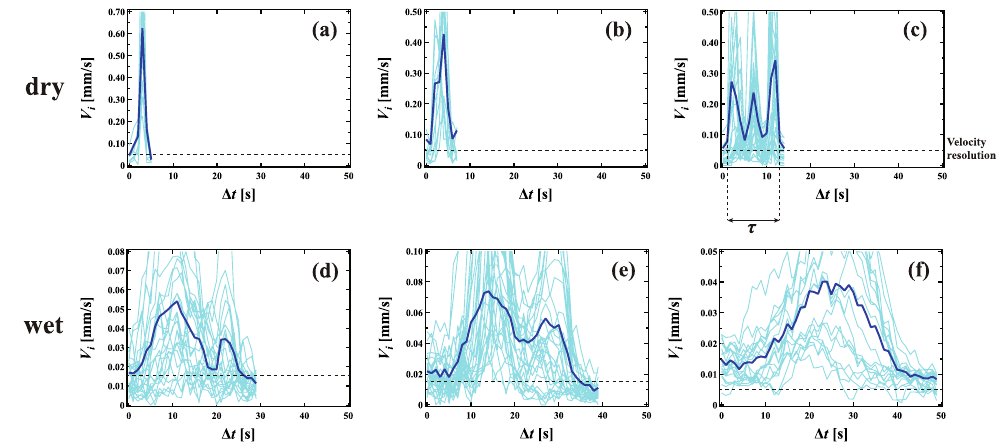
Figure 3. The time evolution of the velocity of the bubbles V i involved in a single collective rearrangement event for φ 2 D = ( a ) 0.019, ( b ) 0.034, ( c ) 0.042, ( d ) 0.047, ( e ) 0.056, and ( f ) 0.066, respectively. The dark blue line shows the mean velocity. We define τ , the characteristic time of a single collective rearrangement event, as the time from the start to the end of the sequence of peaks as shown in ( c